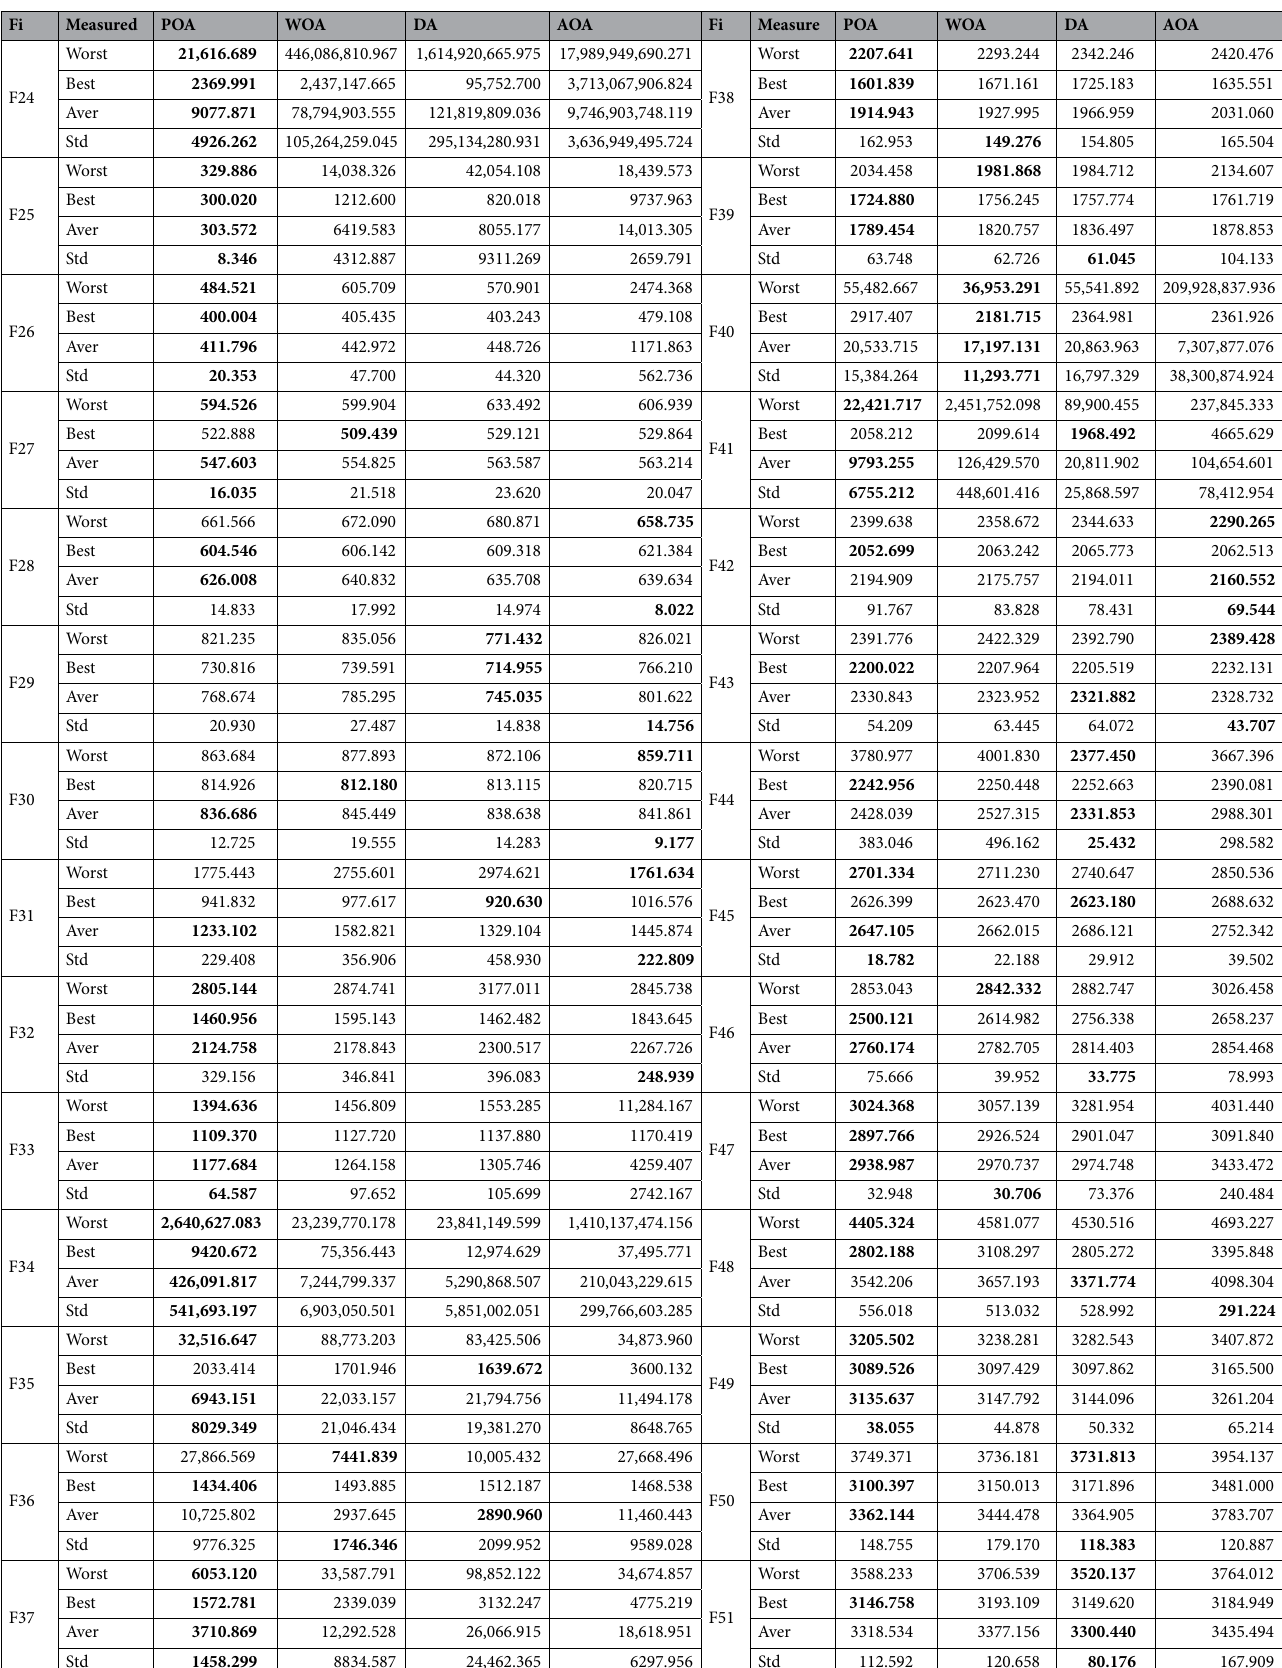
Table 8. Results of CEC 2017 problems. Significant values are in